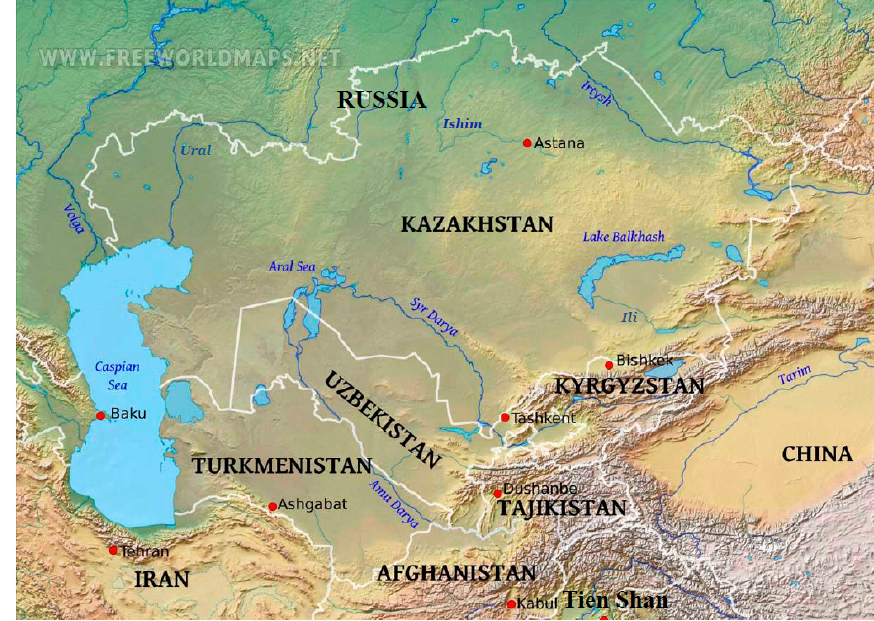
Figure 1. Central Asia with major regional water resources [8].